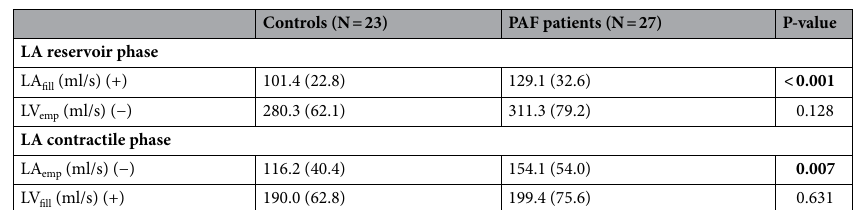
Table 3. Comparison of LV and LA absolute value of slopes derived from the corresponding volume vs time curves during the LA reservoir and contractile phases for PAF patients and controls. Significant values are in bold. The sign indicates the blood volume increases (filling) or decreases (emptying) with time. Variables are expressed as mean (standard deviation). LA left atrium, LA emp LA volume emptying, LA fill LA volume filling, LV left ventricle, LV emp LV volume emptying, LV fill LV volume filling, PAF paroxysmal atrial fibrillation.